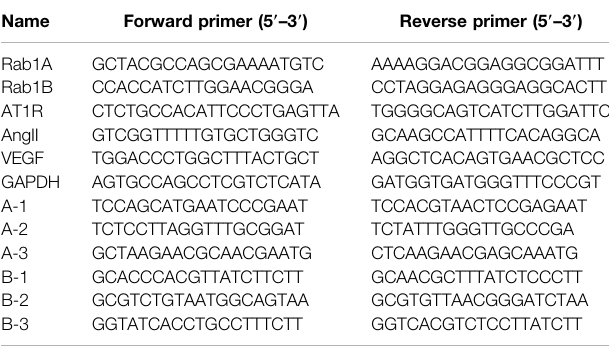
TABLE 2 | Sequences of primers used in vivo and vitro